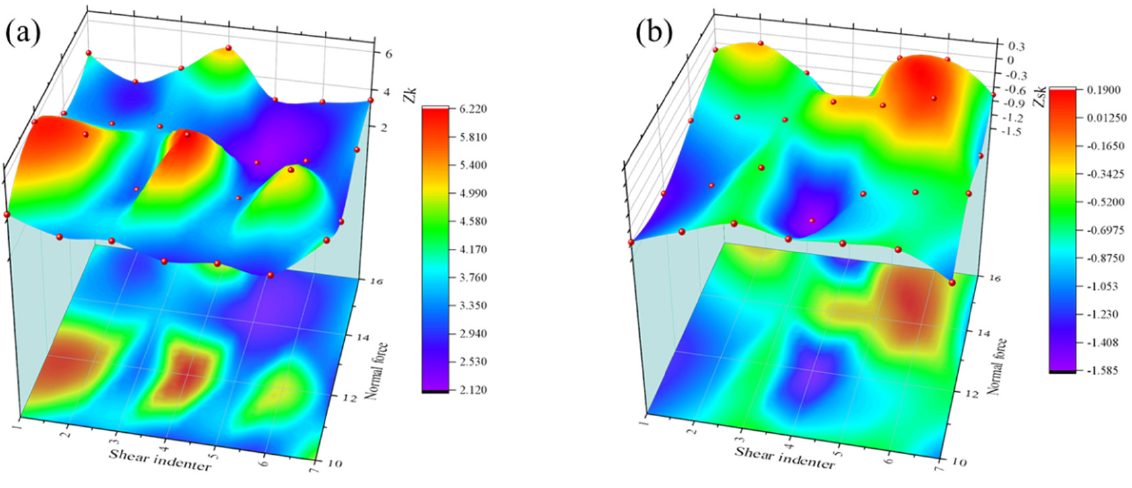
Figure 17. 3D clouds of characteristic parameters in the pressed-in area for different shear indenters and normal forces: ( a ) Z k ( b ) Z Sk .